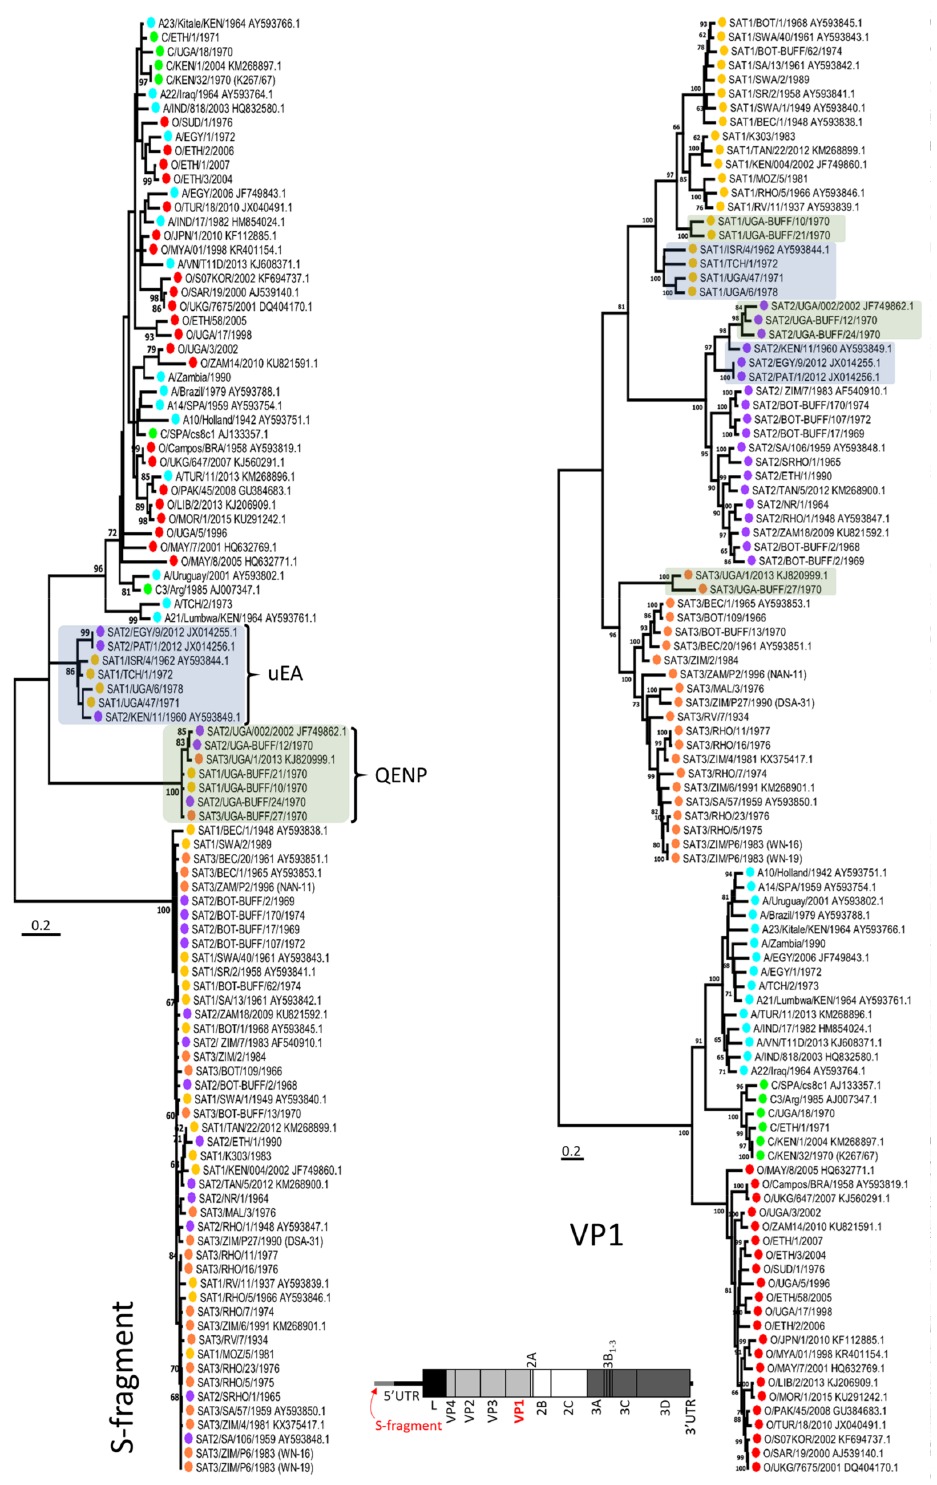
Figure 1. Maximum likelihood (ML) phylogenetic analysis of S-fragment sequences defining two new viral genetic clades (isolates from the Queen Elizabeth National Park (QENP) and “unusual” sequences from East Africa (uEA)). The evolutionary history based on S-fragment and VP1 sequence was inferred using the ML method and general time reversible nucleotide substitution model with gamma distribution and invariant sites (GTR + G + I) (both implemented in MEGA7 software). For each fragment the tree with the highest log likelihood is shown. The percentage of trees (with the 60% cut-off) in which the associated taxa clustered together is shown next to the branches. Initial tree for